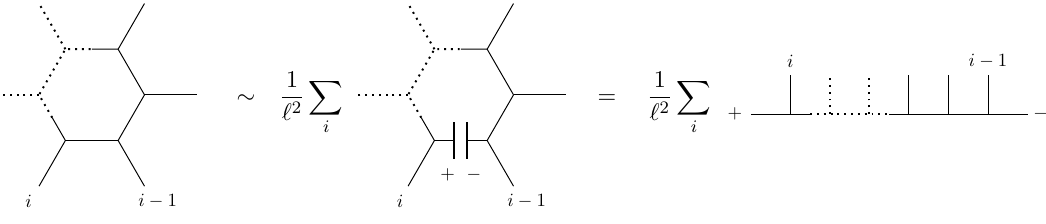
Figure 6 . Decomposition into tree-level-like